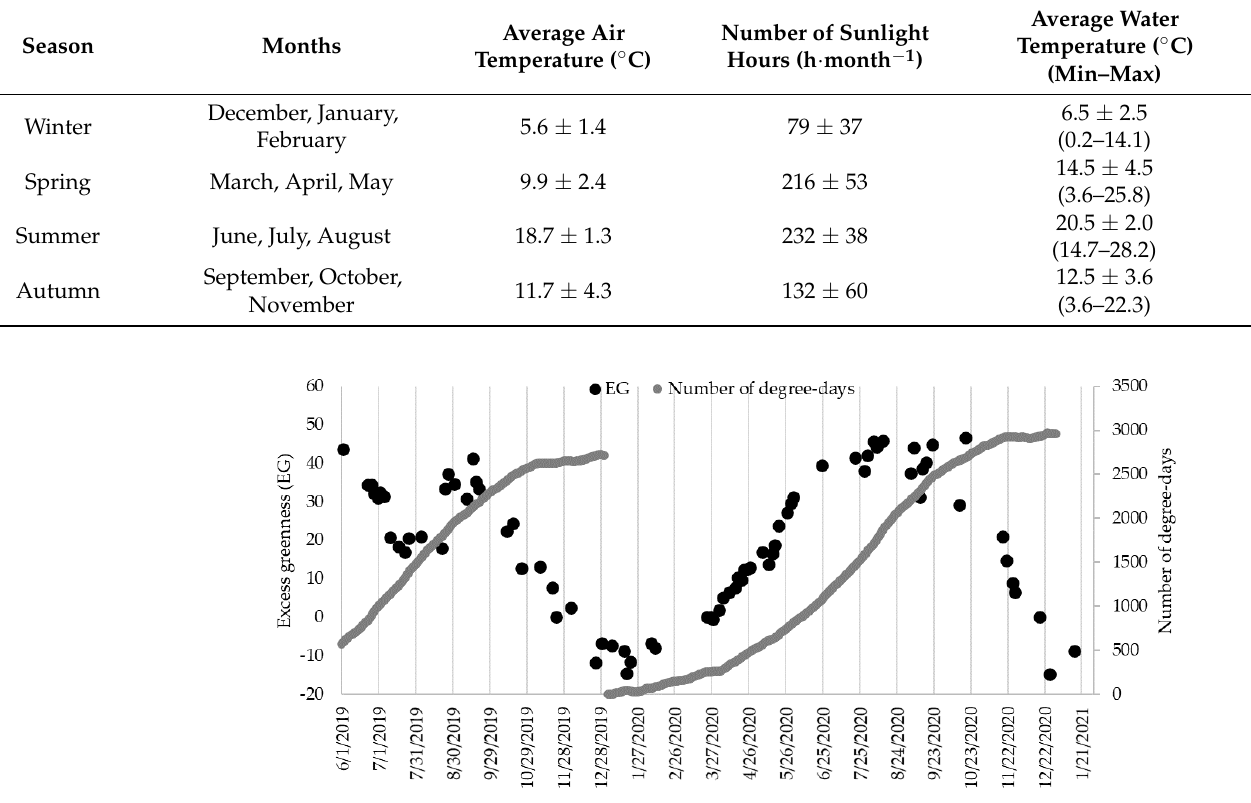
Figure 2. Excess greenness over the basins and annual number of degree-days during the period of study. Table 1. Average air temperature under shelter (°C) and number of sunlight hours (h·month −1 ) for the different seasons during the period of study. Values to the right of (±) are the standard devia- tions.